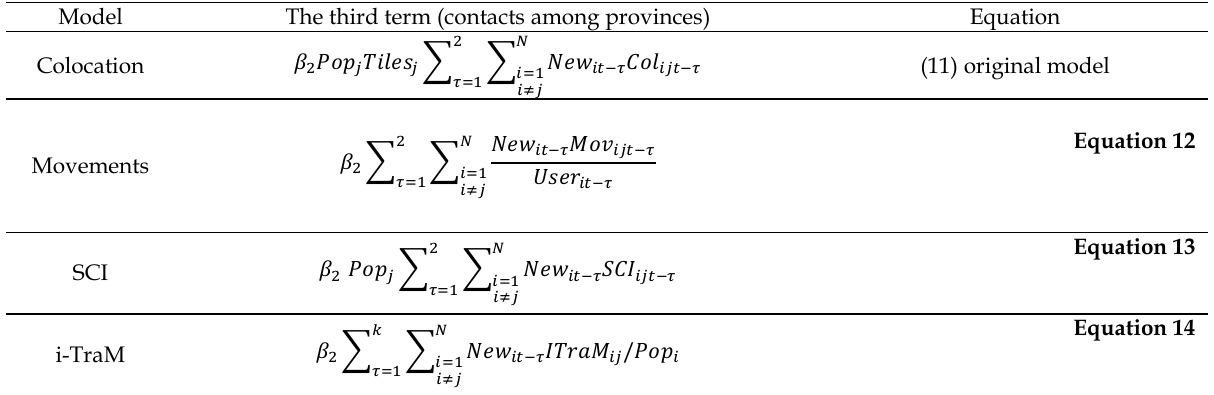
Table 3. Models with different external movements